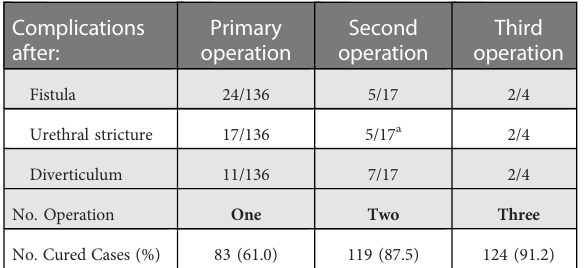
TABLE 1 Characteristics of patients treated with TPIFU. TABLE 2 Operation times of